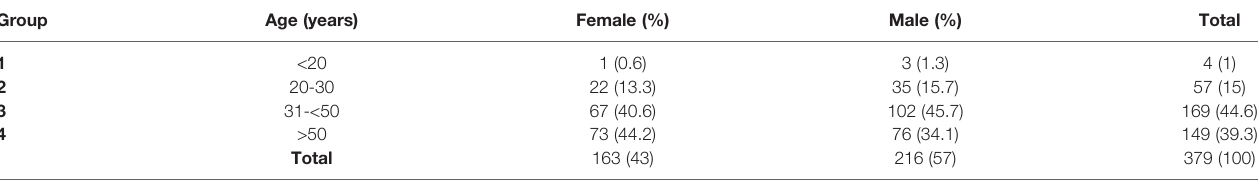
TABLE 1 | Age and gender demographics of the double Sinopharm Vaccinated cohort in this study. Group